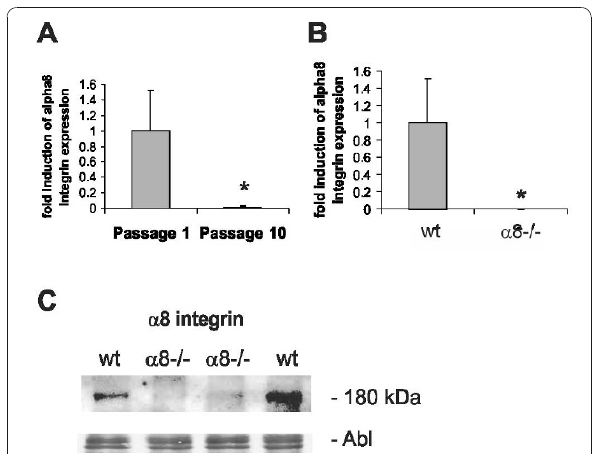
Figure 4 Expression of a 8 integrin in vascular smooth muscle cells . Real-time RT-PCR analysis of a 8 integrin expression in wild type (wt) vascular smooth muscle cells cultivated in passage 1 or 10 (A). Real-time RT-PCR analysis of a 8 integrin expression in freshly isolated wt and a 8-/- vascular smooth muscle cells (B). Western blot analysis of a 8 integrin expression in freshly isolated wt and a 8-/- vascular smooth muscle cells (C). Amido black (Abl) staining of the blot served as loading control. Results are representative for at least 3 similar experiments. Data are means ± sd. * p < 0.05 vs. freshly isolated cells or wt, of f-actin fibers was not different in a 8 integrin-deficient VSMCs compared to wild type VSMCs (Figure 5C and 5D) after 24 hours of attachment. Adherent a 8 integrin-